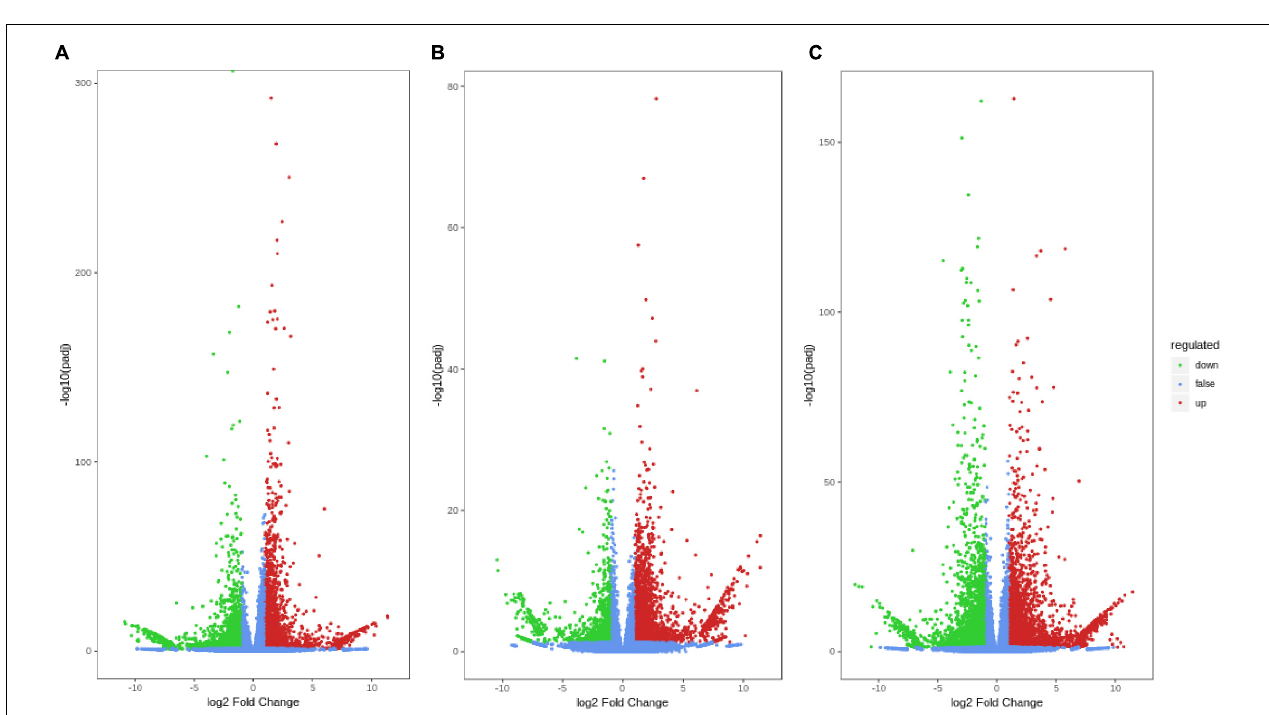
FIGURE 2 | Differential gene volcano maps between inflorescence-removal treatment and non-inflorescence removal controls. (A) A-J vs. B-J (B) A-L vs. B-L (C) A-R vs. B-R. The significant DEGs with | Log 2 (fold change)| ≥ 1 and FDR ≤ 0.05 are represented by green (down-regulated) and red (up-regulated) dots.